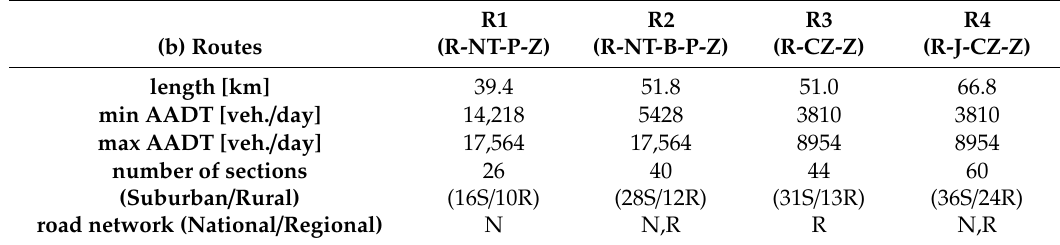
Table 4. Description of the analyzed road network covered by the TTIS by